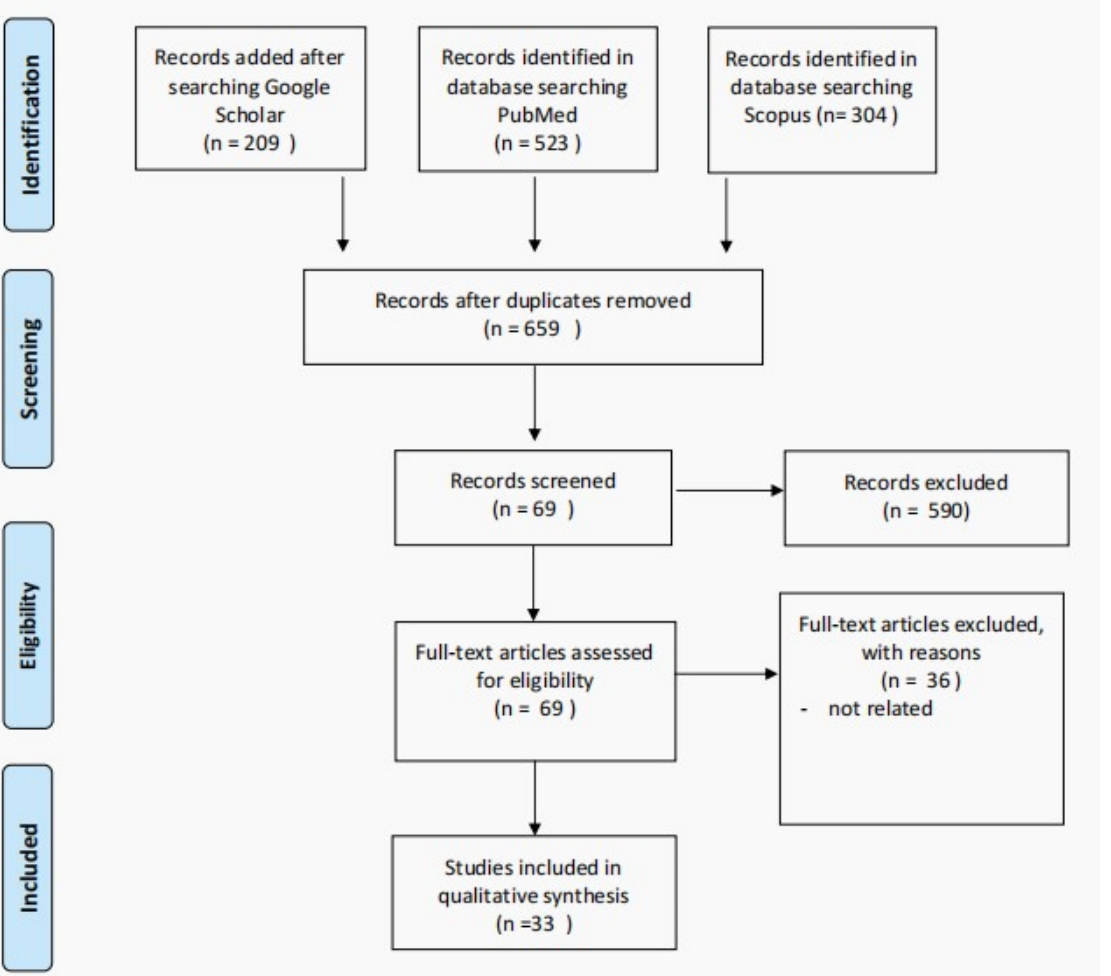
Figure 1. The PRISMA flow diagram detailing patients with the Ph-negative MPNs in pediatric age group.